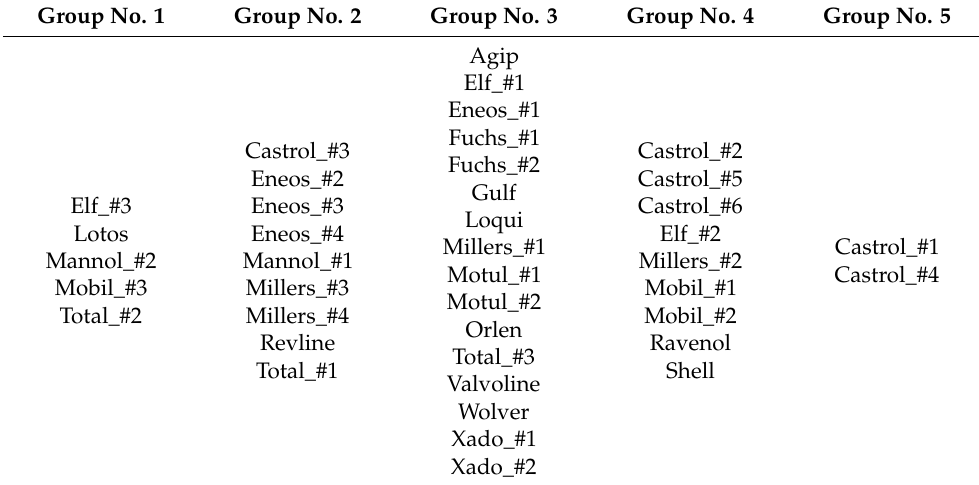
Table 4. Assignment of the oils into different groupings according to the similarity in phase shift values. Group No.